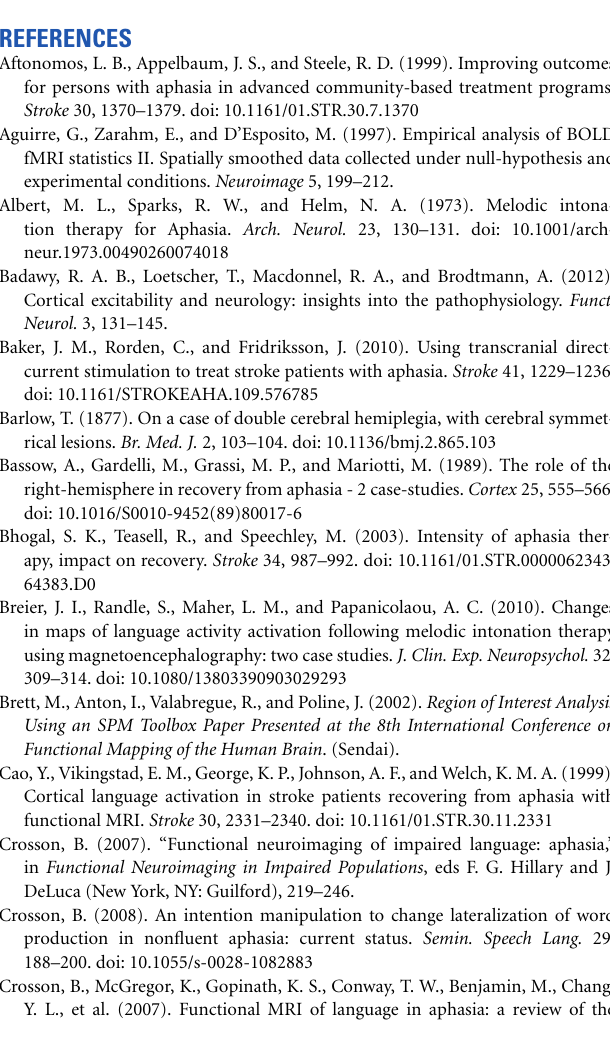
Table S1 | Summary of GOE’s fMRI activation patterns for the main contrasts: pre-treatment > post-treatment and post-treatment > pre-treatment in the automatic speech task. Table S2 | Summary of AMC’s fMRI activation patterns for the main contrasts: pre-treatment > post-treatment and post-treatment > pre-treatment in the automatic speech task. Table S3 | Summary of GOE’s fMRI activation patterns for the main contrasts: (A) pre-treatment > post-treatment and post-treatment